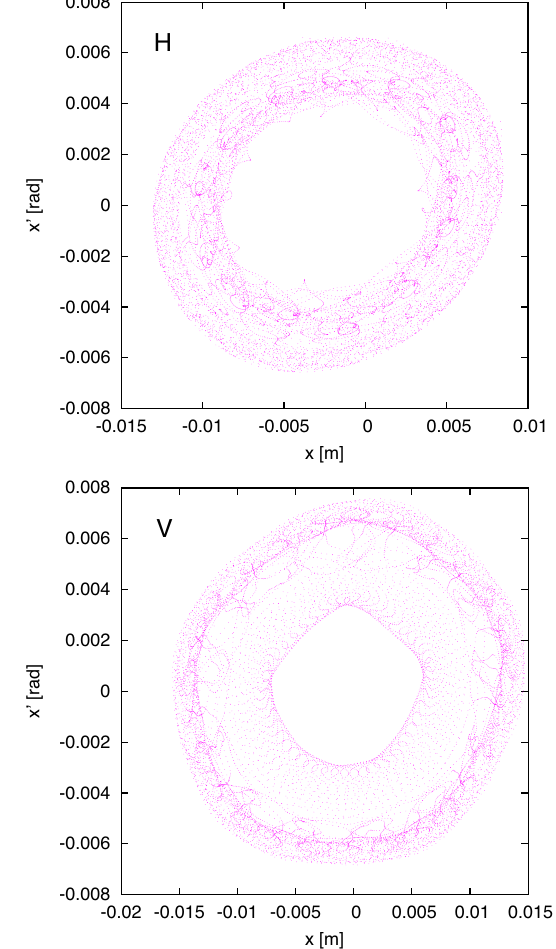
FIG. 11. Phase space plots of a particle near a 4th order resonance, lost after 14211